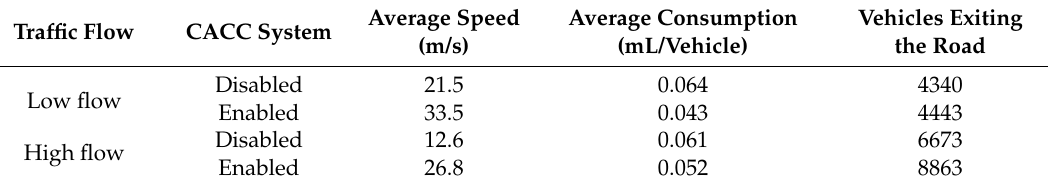
Table 5. Results of the simulation